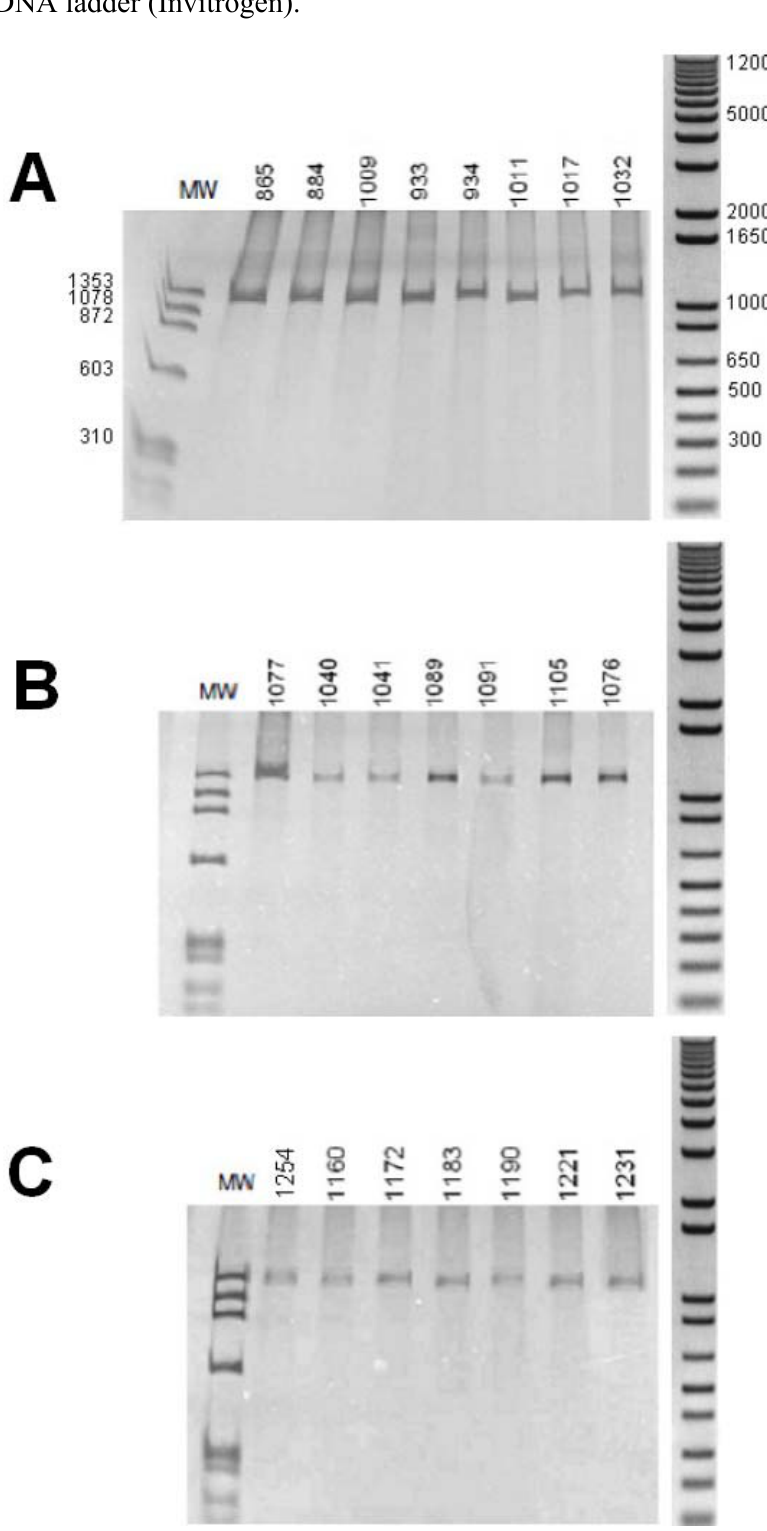
Figure 1. Polyacrylamide gel electrophoresis with silver stain. Amplification of intron 1 of the myoglobin gene. ( A ) B. glabrata ; ( B ) B. straminea ; ( C ) B. tenagophila . Numbers above the lane are one different individual. MW = molecular weight (base pairs) of  X174/ Hae III digested (Amersham Biosciences). On right: molecular weight (base pairs) of 1 kb Plus DNA ladder